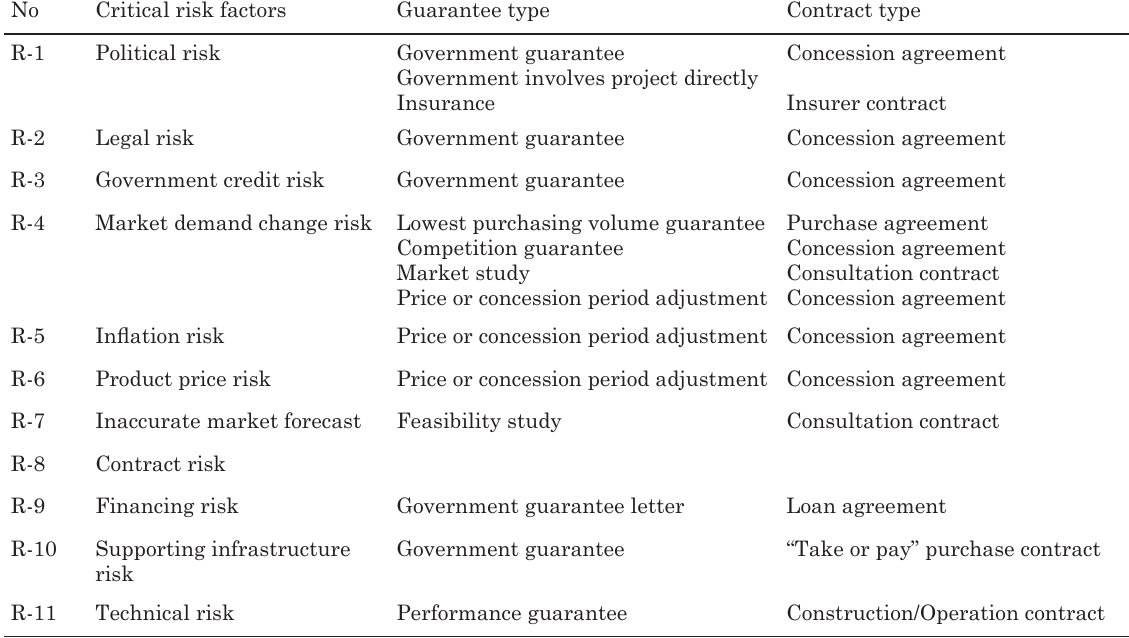
table 5. risk guarantee structure of PPP water projects in